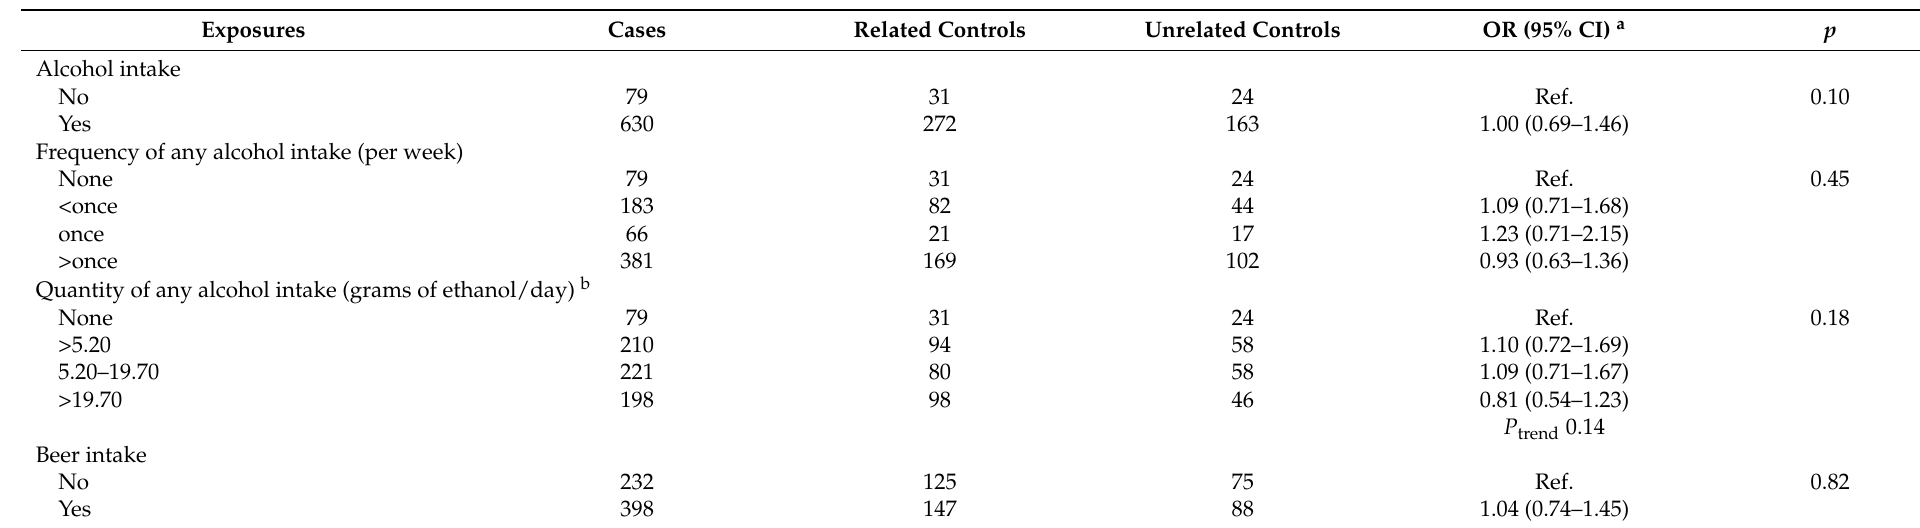
Table 4. Odds ratios and 95% confidence intervals for FL risk in relation to alcohol intake 12 months prior to